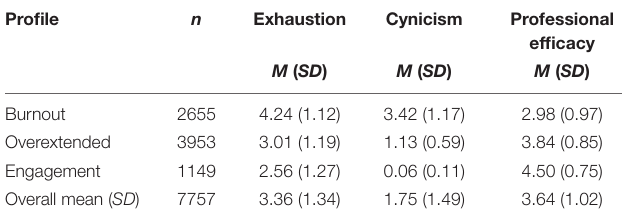
TABLE 5 | Descriptive statistics MBI scale by